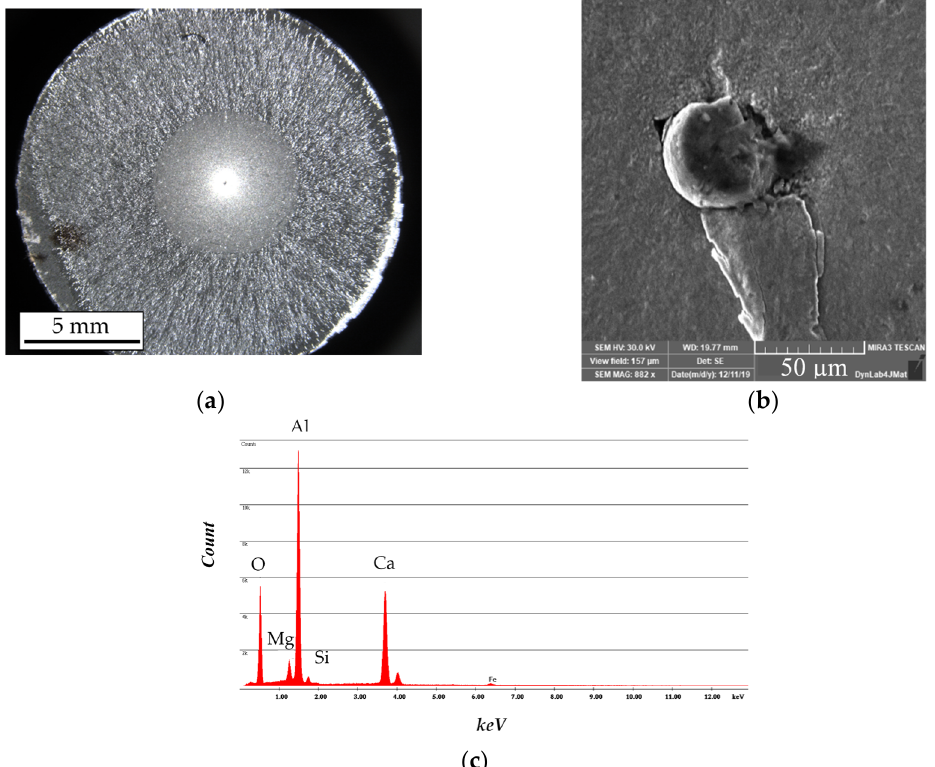
Figure 6. Fracture surfaces and analysis of defects: ( a ) fish-eye fracture in Gaussian specimen (optical microscope); ( b ) example of a spherical inclusion originating failure (SEM image); ( c ) typical EDX spectrum taken at the center of an inclusion originating the fatigue failure.